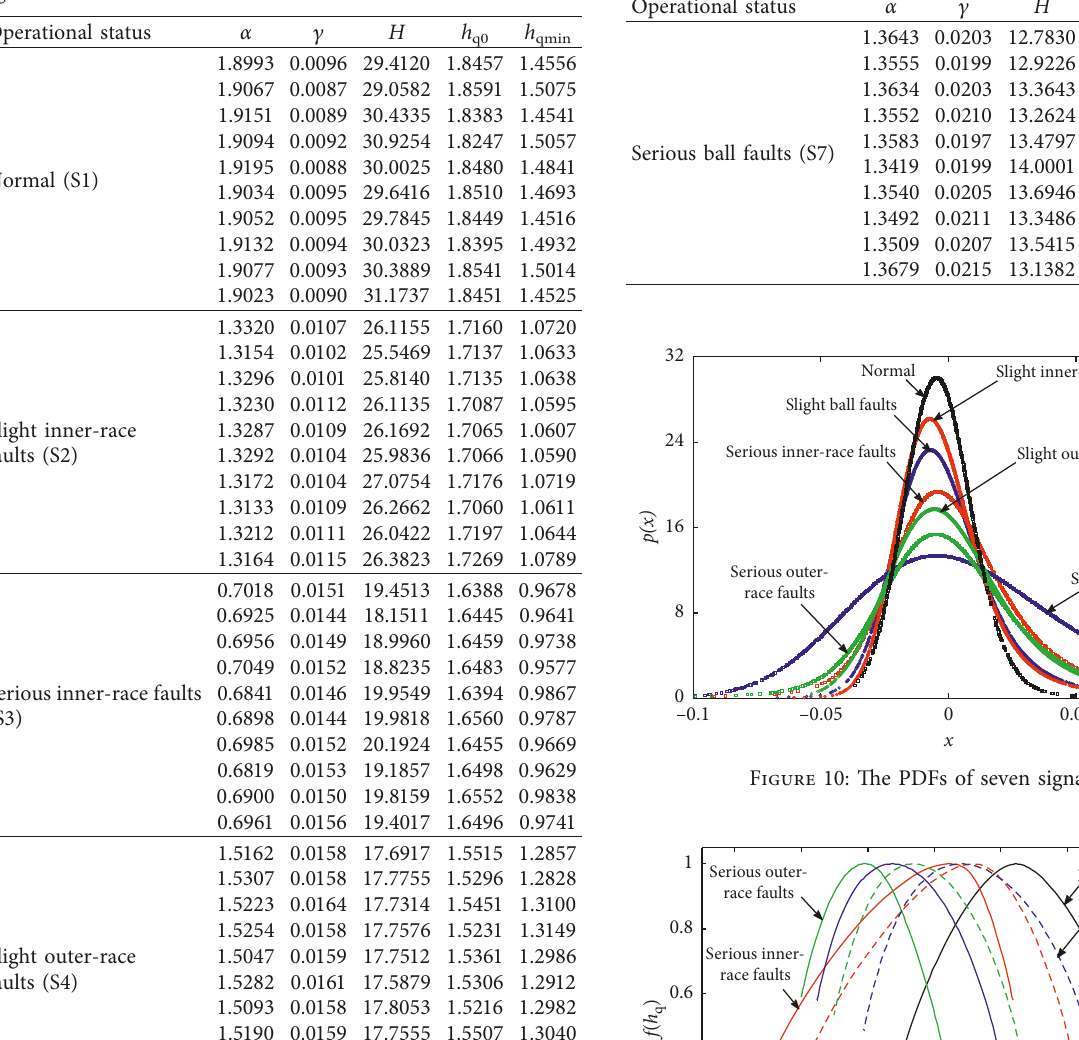
Table 3: The detailed descriptions of seven vibration acceleration signals.